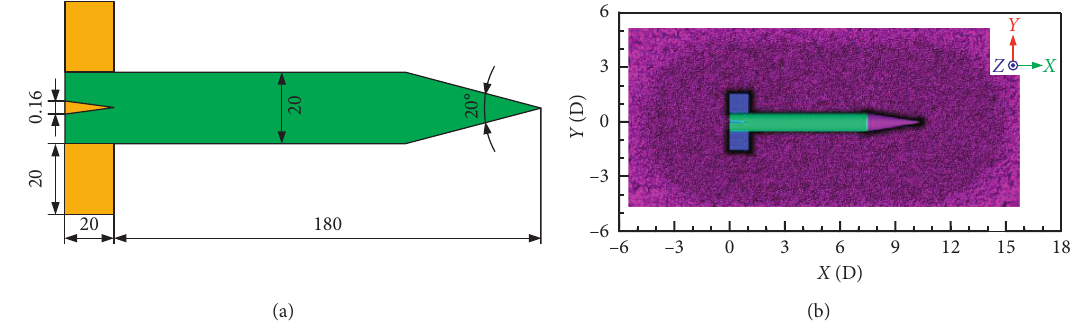
Figure 4: ANF verification model: (a) ANF parameters (mm) and (b) computed grid.